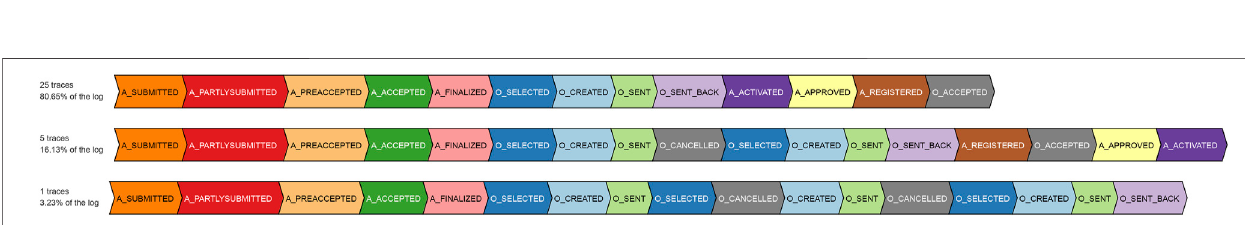
Frontiers in Big Data |